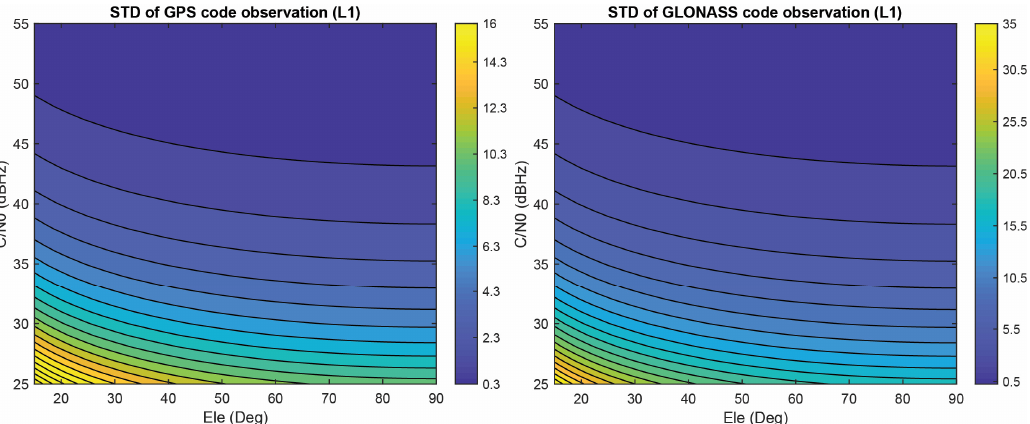
Figure 8. Estimated STD for GPS and GLONASS code observations on L1 frequency (in meters).